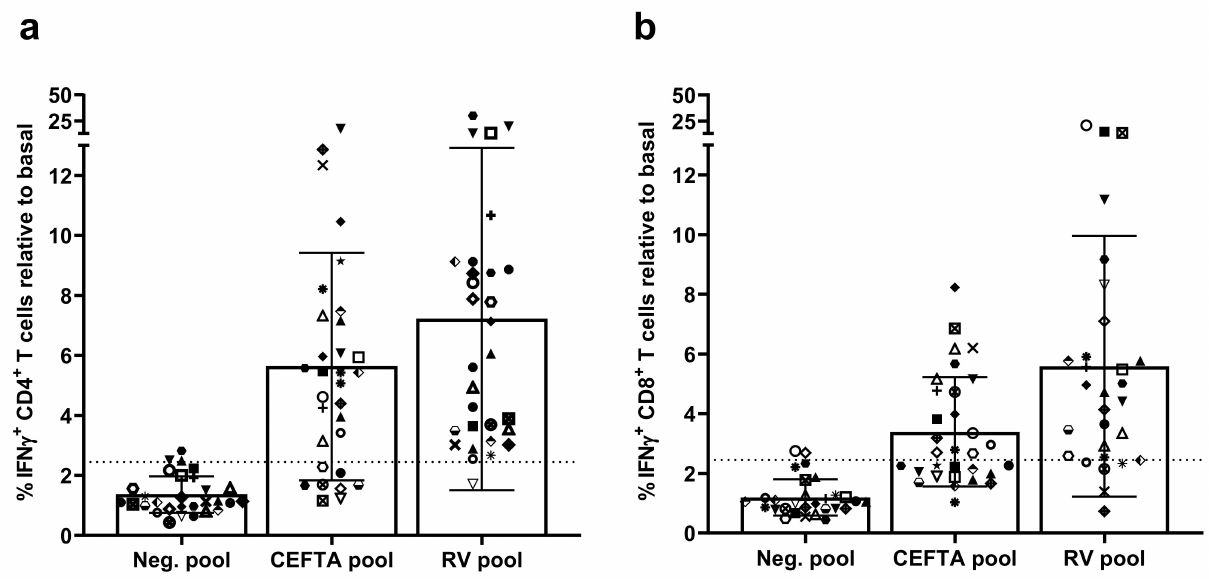
Figure 4. T cell responses to the rhinovirus (RV)-specific CD4 T cell epitope pool. Interferon gamma (IFN γ )-production by CD4 ( a ) and CD8 ( b ) T cells in response to different peptide pools. Peripheral blood mononuclear cells (PBMCs) from 30 donors were expanded and stimulated with a peptide pool containing 10 µ M of each RV-specific CD4 T cell epitope identified in this study in the presence of Brefeldin A, labeled with anti-CD4 and anti-CD8 antibodies and stained intracellularly for IFN γ (see Materials and Methods). Results are expressed as the percentage of peptide-specific IFN γ - producing CD4 or CD8 T cells within the total of gated-CD4 or CD8 T cells as relative to the basal IFN γ production of each donor. Basal IFN γ production was obtained by incubating donor PBMCs without the addition of exogenous peptide. The CEFTA peptide pool was used as a positive control, and as a negative control, we used a peptide pool containing four irrelevant peptides (see Materials and Methods). Each individual symbol represents a different donor. Mean and standard deviation of all donors tested are plotted. The vertical line represents the threshold used as selection criteria for positive responses (>2.5% IFN γ + CD4 + or CD8 + T cells fold increase as relative to